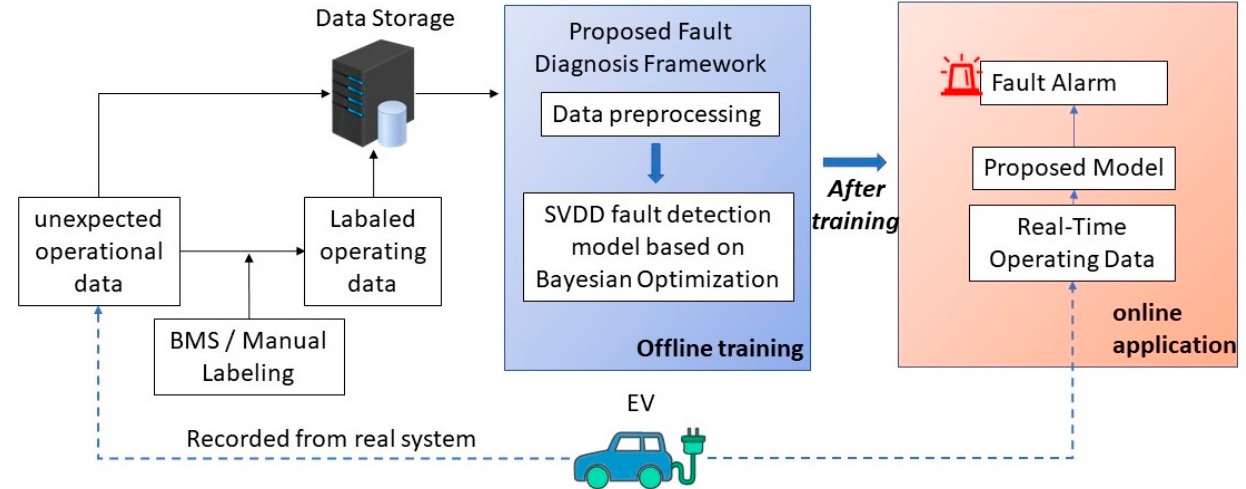
Figure 16. Fault detection proposed application for EV battery by [155].